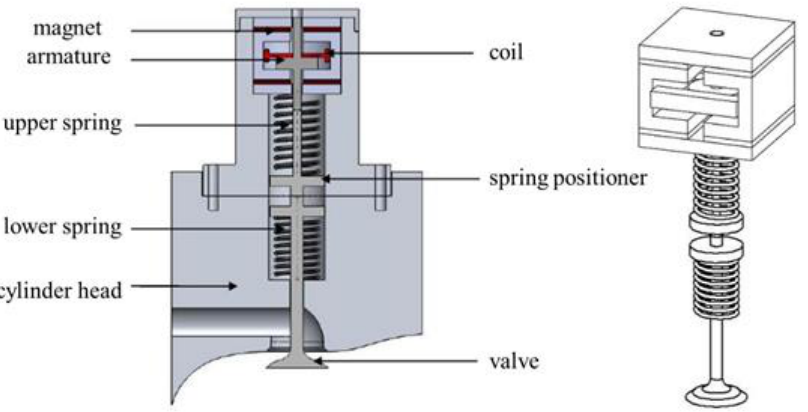
Figure 1. Schematic diagram of permanent magnet electromagnetic composite electronic valve [15].